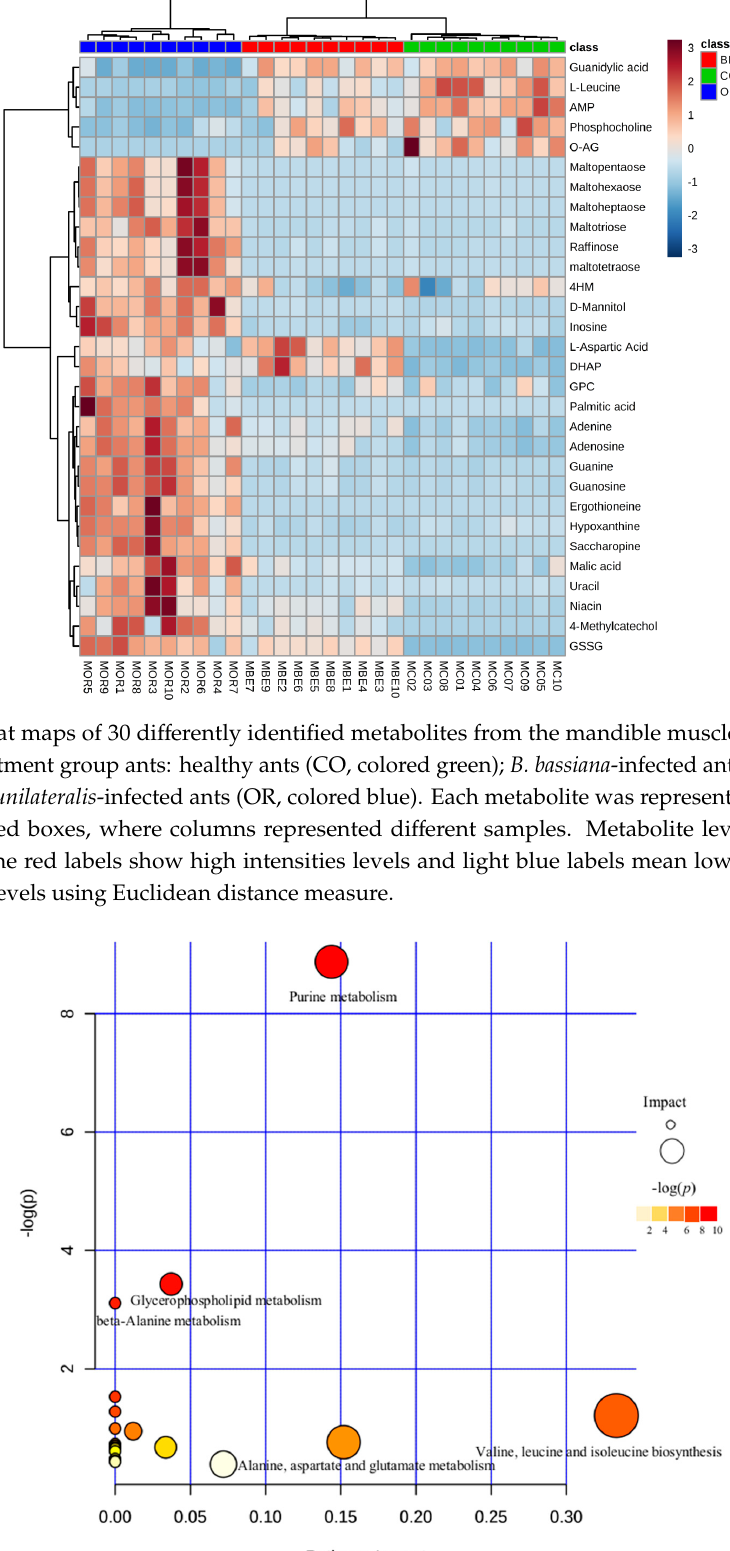
Figure 6. Pathway analysis for the O. unilateralis group vs. B. bassiana and the uninfected group.